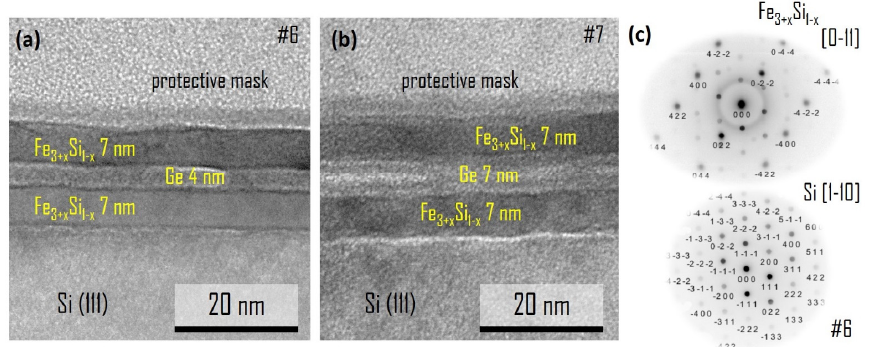
Figure 2. TEM images of cross section of Fe 3+ x Si 1 − x /Ge/ Fe 3+ x Si 1 − x /Si(111) samples #6 ( a ) and #7 ( b ). Unit cell and crystallographic plane with iron atoms of the Fe 3+ x Si 1 − x epilayer in the (111) film plane ( c ).